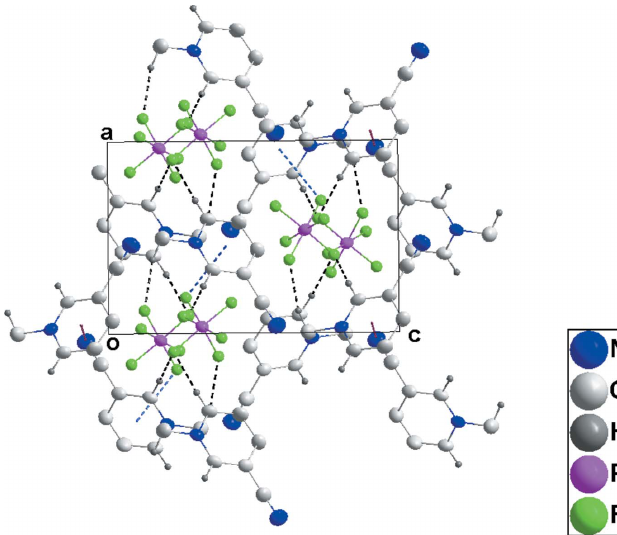
Figure 4 Side view of two cation and anion columns in 1 projected onto (021). C—